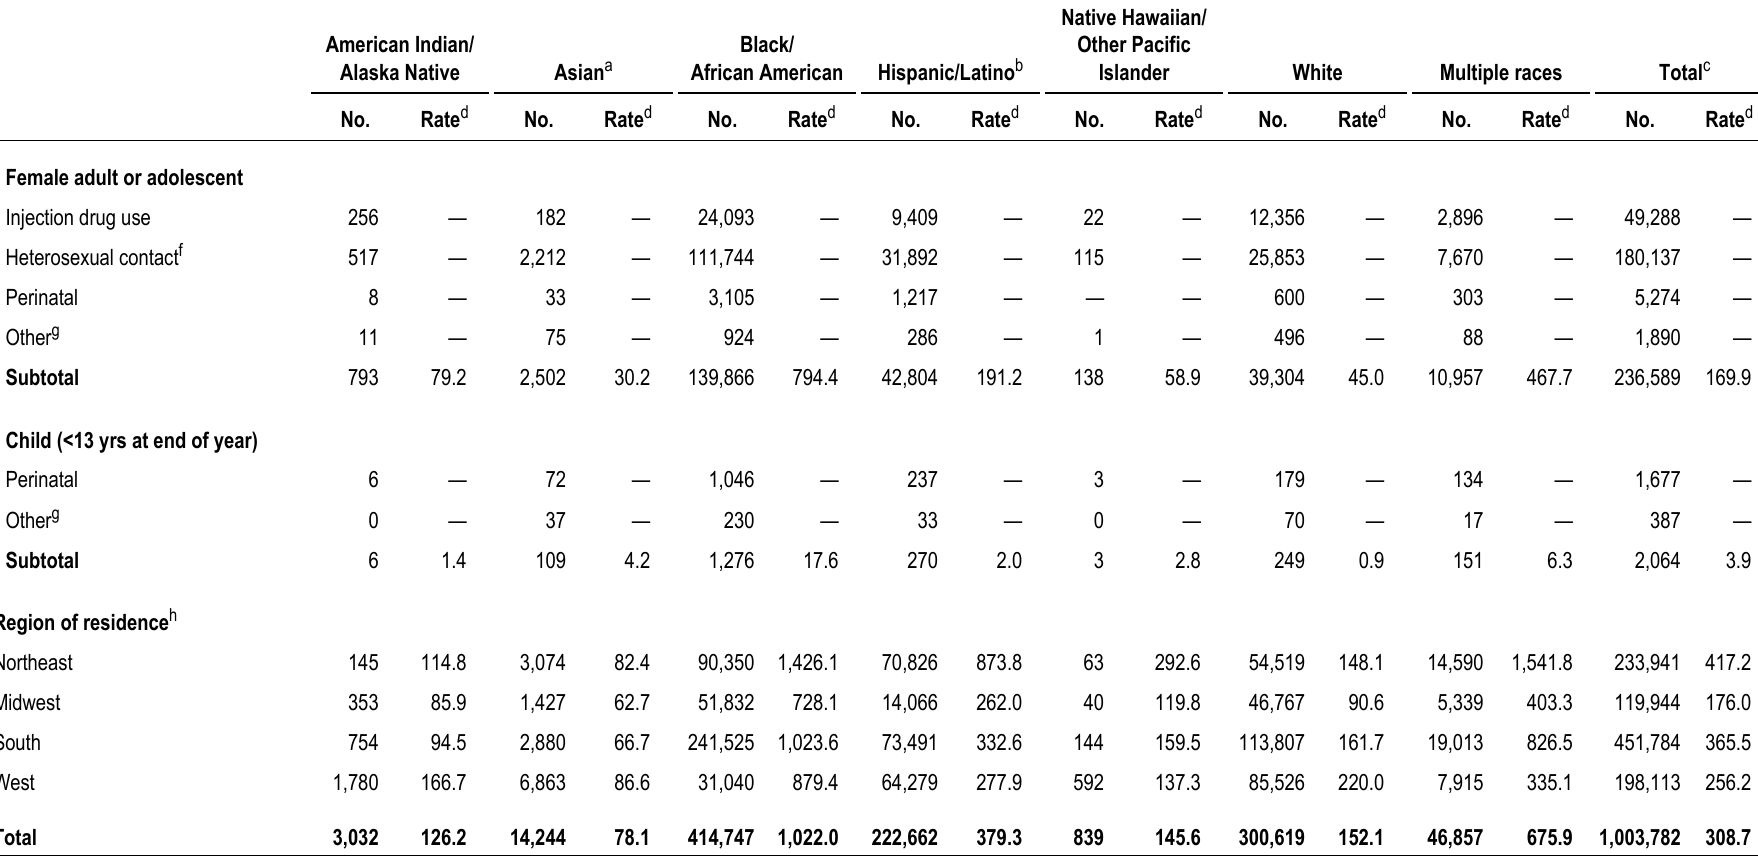
Table 24a. Persons living with diagnosed HIV infection, by race/ethnicity and selected characteristics, year-end 2017—United States